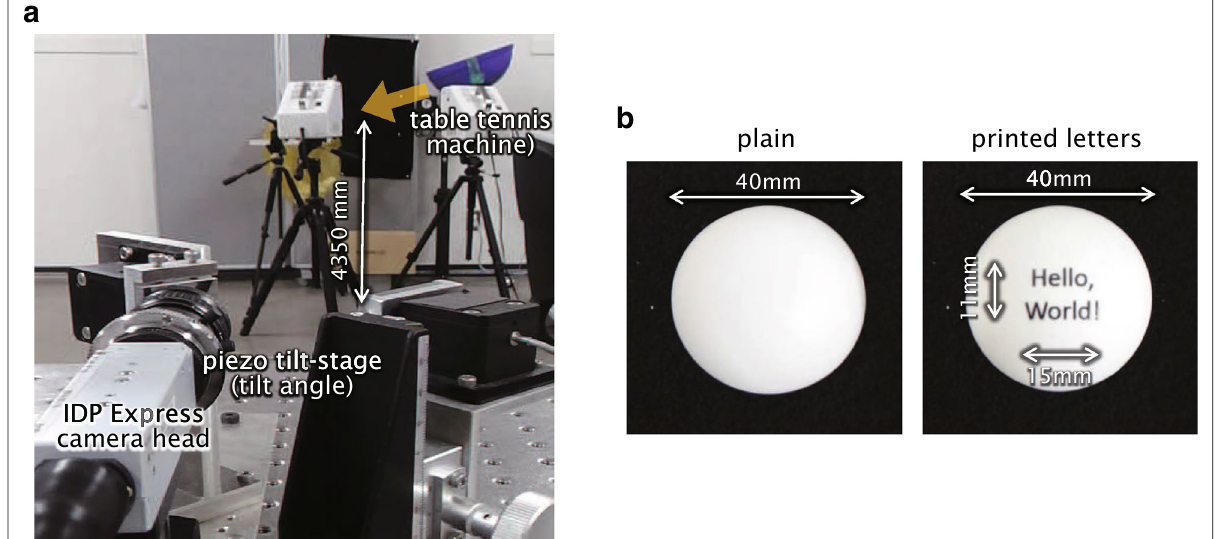
Fig. 15 Experimental environment and observed table tennis balls. a Overview. b Table-tennis balls to be evaluated